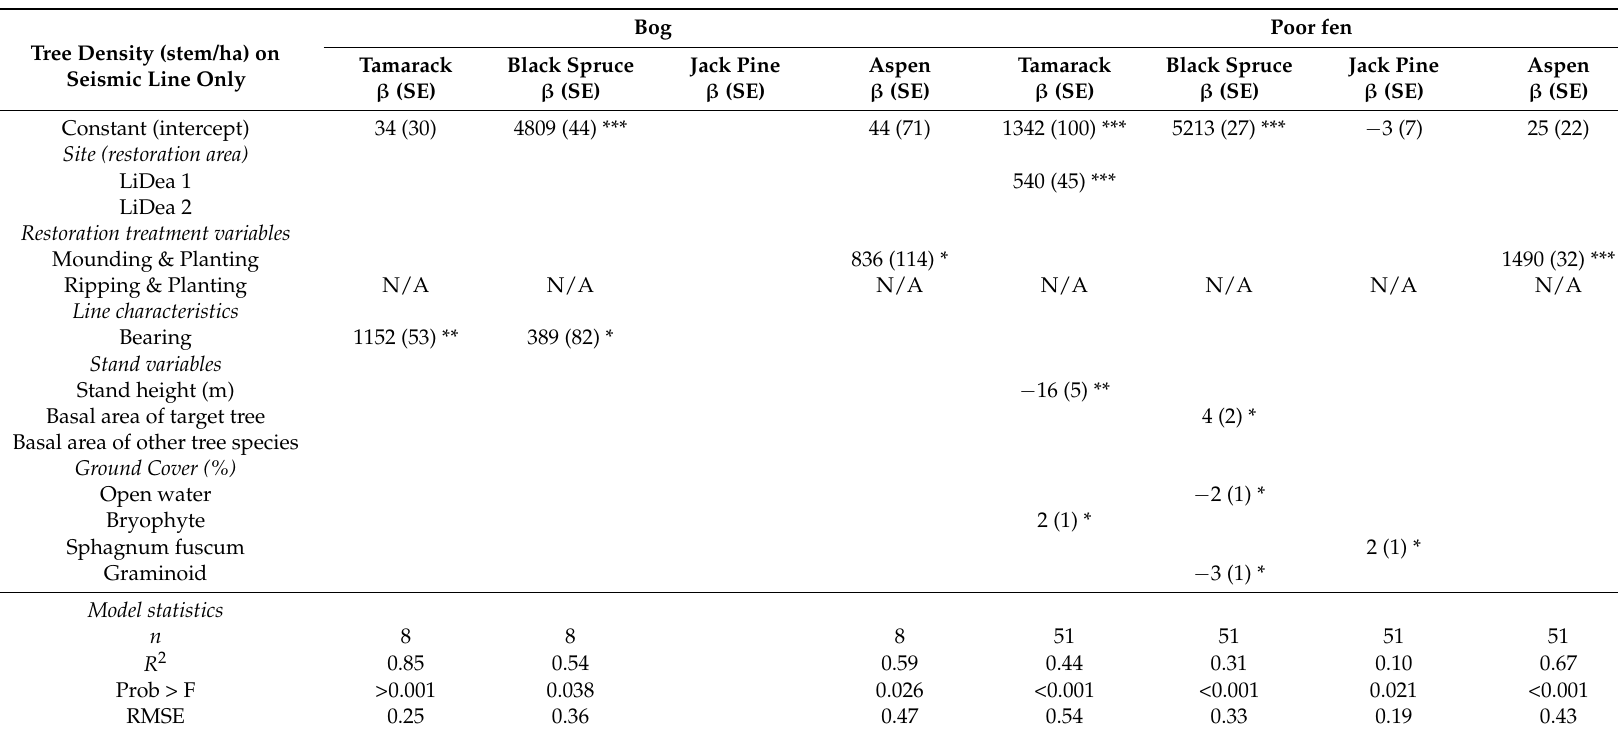
Table A2. Linear regression model parameters (coefficient, β ; and standard error, SE) relating regeneration density (log 10 transformed) of all tree species found on seismic lines to restoration treatment, line characteristics, stand variables, and percent ground cover. *** p < 0.001, ** p < 0.01, * p < 0.05. RMSE is root mean squared